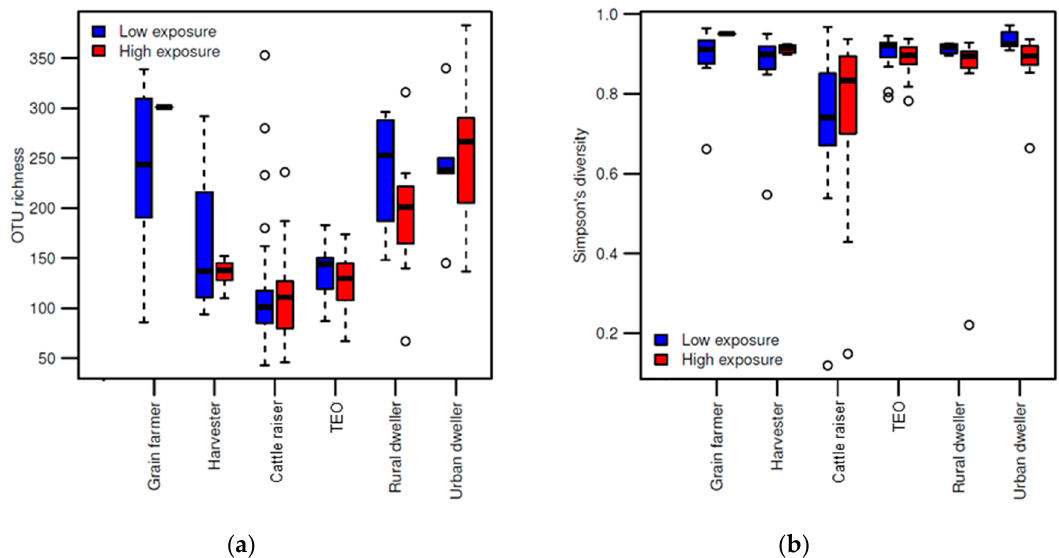
Figure 1. Fungal diversity among occupation groups according to the wheat dust exposure period: low or high. ( a ) Boxplot of OTU (operational taxonomic unit) richness among samples collected in the environment of each occupational group; ( b ) and of Simpson’s diversity among the same samples. The center line represents the median richness / diversity values, while the box represents the interquartile range and the whiskers the 1.5 times interquartile range.